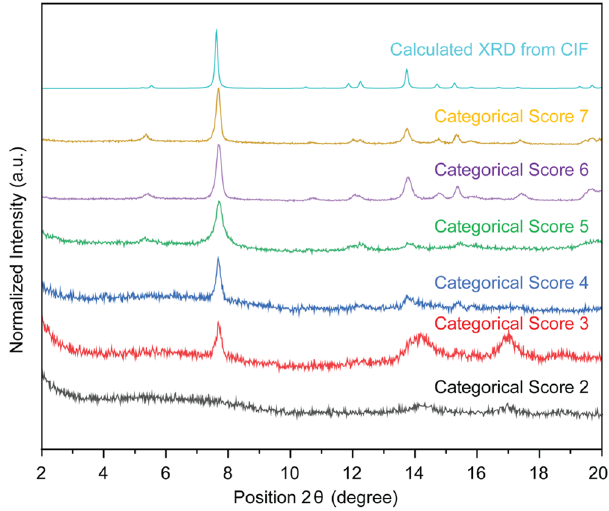
Fig. 2 PXRD patterns of samples obtained in generation 1 for each categorical score ranging from 1 to 8. PXRD of the best and worst samples produced from the fi rst generation of experiments, with the calculated XRD from the CIF of Al-PMOF. The categorical score was given on a scale from 1 (worst) to 10 (best) in terms of